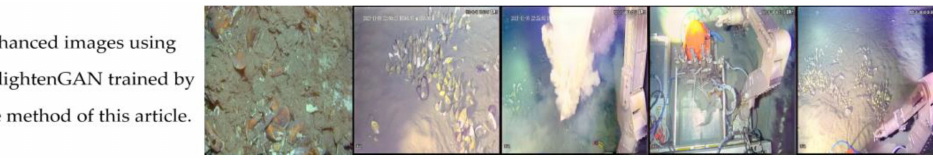
Figure 9. Enhanced images using